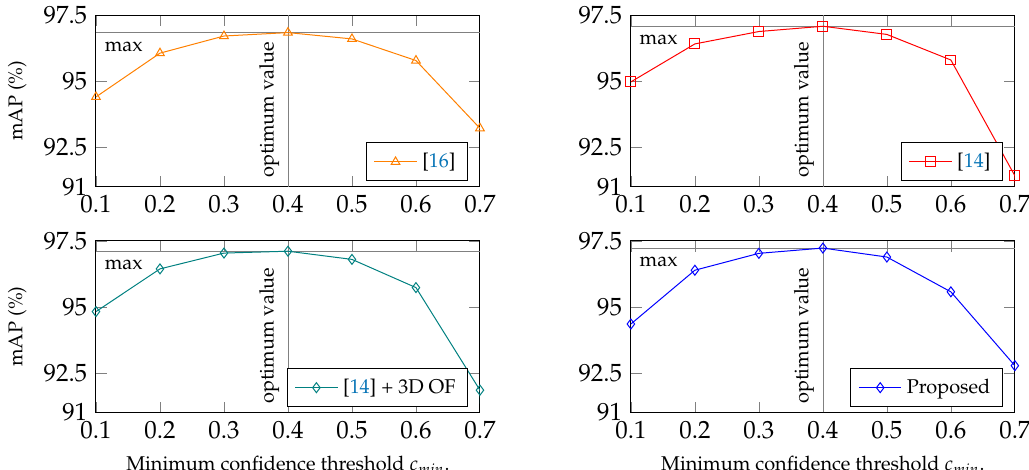
Figure 12. Mean Average Precision based on Percentage of Correct Keypoints thresholds ( a = 0.05) against confidence threshold, mAP ( c min )